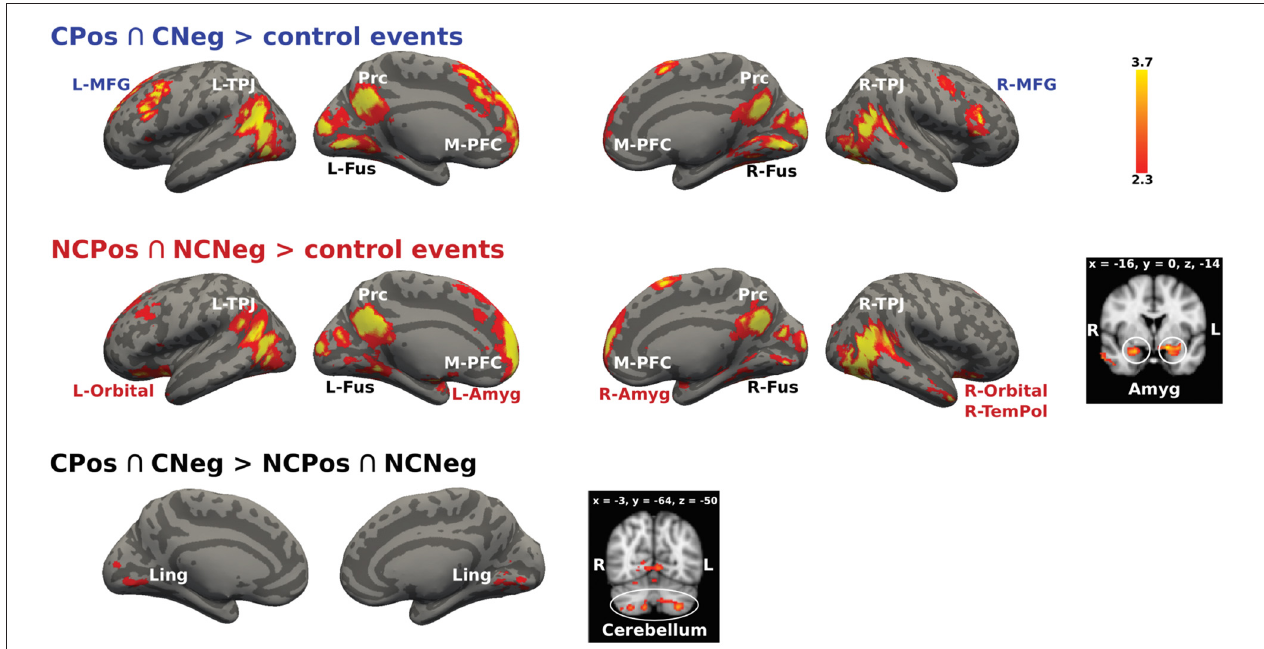
FIGURE 5 | Activation maps for two confederates. A whole-brain contrast for cooperative confederate (CPos ∩ CNeg) with respect to control events (CPos ∩ CNeg > control events) revealed increased activity in bilateral TPJ, Prc, medial prefrontal cortex (M-PFC), bilateral cortex fusiform (Fus), and bilateral middle frontal gyrus (MFG). Additionally, contrast for cooperative (NCPos ∩ NCNeg) with respect to control events (NCPos revealed increased activity in bilateral temporoparietal junction NCNeg > control events), includes increased activity in amygdala (Amyg), bilateral orbitofrontal cortex (Orbital), and right temporal pole (R-TemPol). Contrast between confederates, CPos ∩ CNeg > NCPos ∩ NCNeg showed a bigger activity in visual areas and cerebellum for cooperative confederate with respect to the non-cooperative confederate, the inverse contrast (NCPos ∩ NCNeg > CPos ∩ CNeg) did not detect any activation. Color bar indicates z